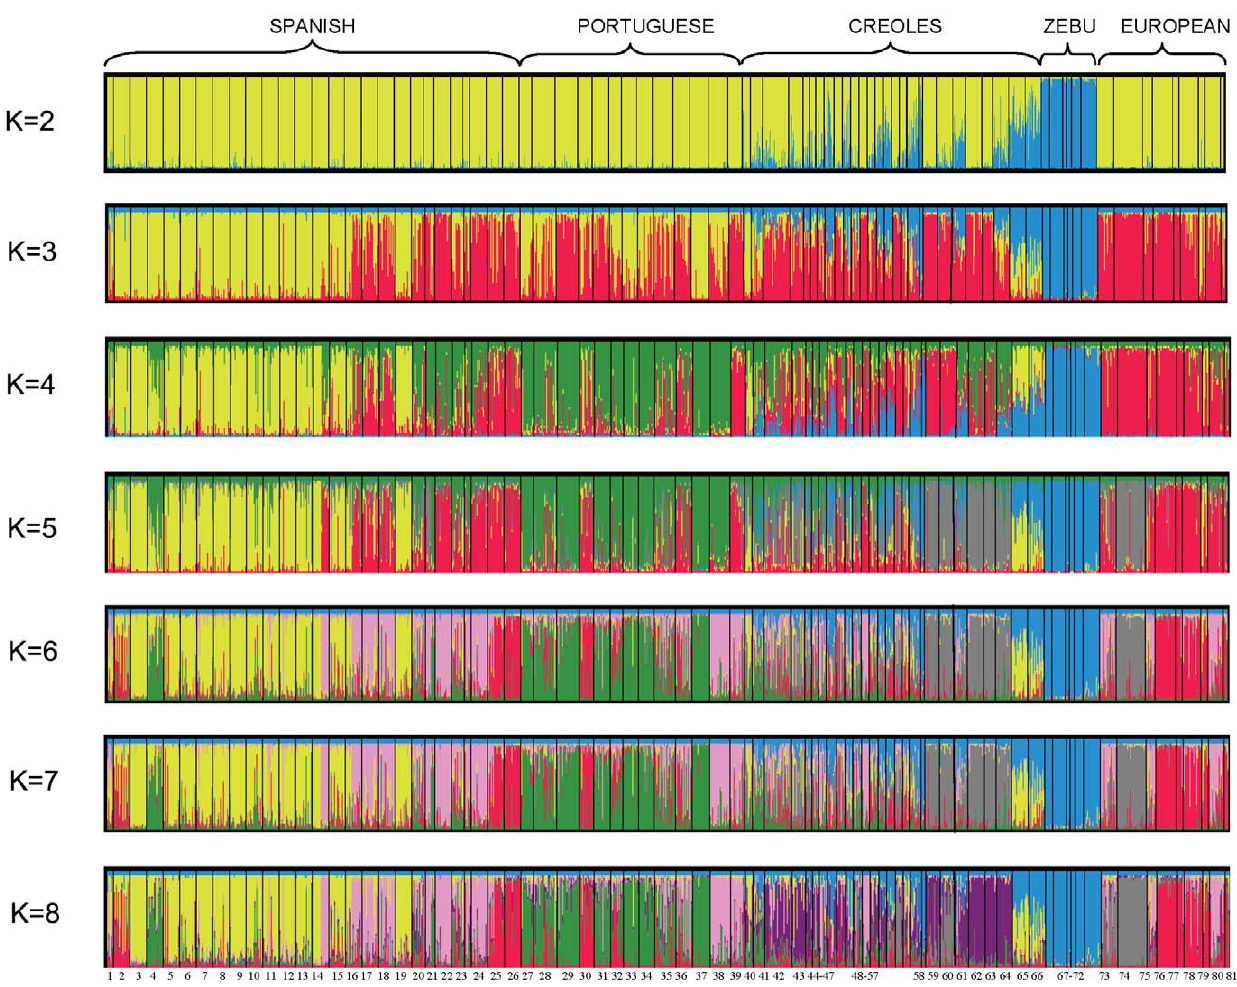
Figure 4. Population structure of 81 cattle breeds based on 19 microsatellite loci using STRUCTURE. Graphical representation of individual genotype membership coefficients (q) when K=2 to K=8. Each animal is represented by a single vertical line divided into K colours, where K is the number of clusters assumed and the coloured segment shows the individual’s estimated membership proportions in that cluster. Black lines separate the populations. SPANISH . 1: Betizu (BET), 2: Toro de Lidia (TL), 3: Menorquina (MEN), 4: Alistana (ALS), 5: Sayaguesa (SAY), 6: Tudanca (TUD), 7: Asturiana de los Valles (ASV), 8: Asturiana de las Montan˜as (ASM), 9: Retinta (RET), 10: Morucha (MOR), 11: Avilen˜a (AVI), 12: Pirenaica (PIRM), 13: Rubia Gallega (RGA), 14: Mallorquina (MALL), 15: Monchina (MON), 16: Serrana de Teruel (STE), 17: Parda de Montan˜a (PM), 18: Bruna de los Pirineos (BRP), 19: Pasiega (PAS), 20: Berrenda en Colorado (BC), 21: Berrenda en Negro (BN), 22: Marismen˜a (MAR), 23: Pajuna (PAJ), 24: Negra Andaluza (NAN), 25: Vaca Canaria (VCA), 26: Vaca Palmera (PAL); PORTUGUESE . 27: Alentejana (ALT), 28: Arouquesa (ARO), 29: Barrosa˜ (BARR), 30: Brava de Lide (BRAV), 31: Cachena (CACH), 32: Garvonesa (GARV), 33: Marinhoa (MARI), 34: Maronesa (MARO), 35: Mertolenga (MERT), 36: Minhota (MINH), 37: Mirandesa (MIRA), 38: Preta (PRET), 39: Ramo Grande (RG); CREOLE . 40: Guabala´ (GUA), 41: Guaymı´ (GY), 42: Texas Longhorn (TLH), 43: Criollo Poblano (CPO), 44: Criollo de Baja California (CBC), 45: Criollo de Chihuahua (CHU), 46: Criollo de Nayarit (CNY), 47: Criollo de Chiapas (CHI), 48: Blanco Orejinegro (BON), 49: Caqueten˜o (CAQ), 50: Sanmartinero (SM), 51: Romosinuano (RMS), 52: Costen˜o con Cuernos (CCC), 53: Chino Santandereano (CH), 54: Velasquez (VEL), 55: Lucerna (LUC), 56: Harto´n del Valle (HV), 57: Criollo Casanaren˜o (CC), 58: Criollo Ecuatoriano (EC), 59: Criollo Uruguayo (CUR), 60: Pampa Chaquen˜o (PA), 61: Criollo Pilcomayo (PIL), 62: Criollo Argentino (CARG), 63: Criollo Patago´nico (PAT), 64: Caracu´ (CAR), 65: Cubano (CUB), 66: Siboney (SIB); ZEBU : 67: Gyr (GYR), 68: Brahman (BRH), 69: Sindi (SIN), 70: Guzerat (GUZ), 71 Nelore (NEL), 72: Zebu Cubano (CUZ); BRITISHANDCONTINENTAL EUROPEAN. 73: Friesian (FRI), 74: Hereford (HER), 75: Brown Swiss (BSW), 76: Aberdeen Angus (AA), 77: British White (BWC), 78: Charolais (CHAR), 79: Jersey (JER), 80: Limousin (LIM), 81: Shorthorn (SH).